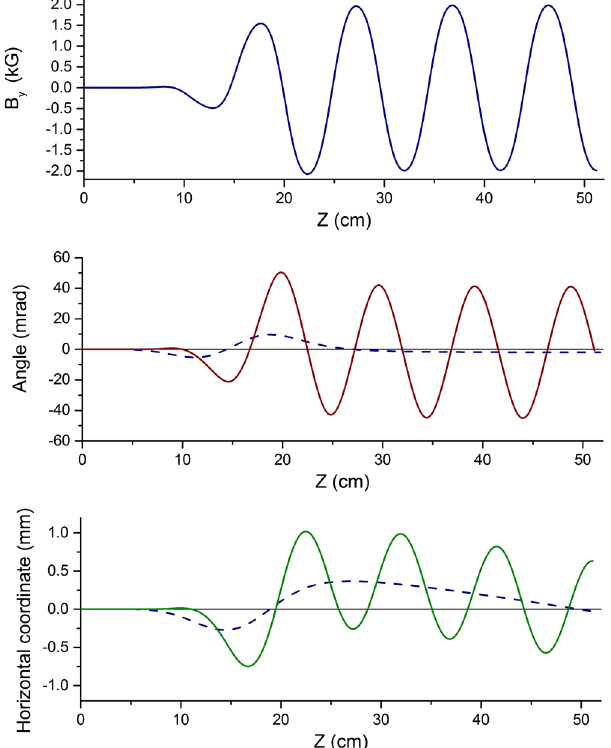
FIG. 16. Vertical magnetic field behavior near the termination, as well as electron horizontal angle and coordinate (undulator period is 9.6 cm, dashed lines correspond to period-averaged values).